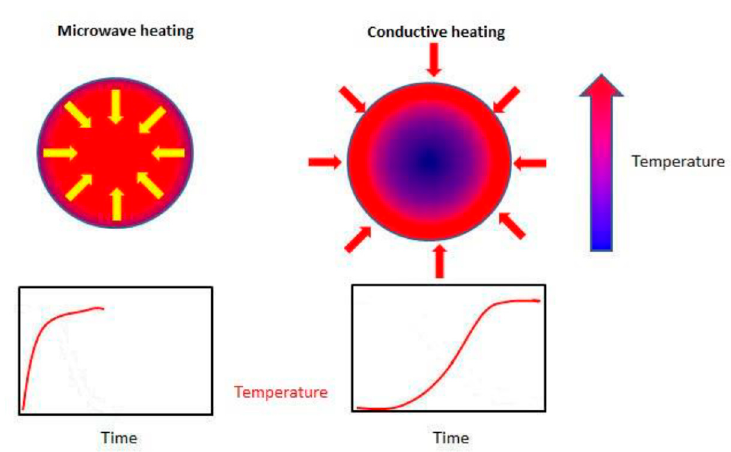
Figure 3. Di ff erence between microwave and conductive Figure 3. Difference between microwave and conductive heating.